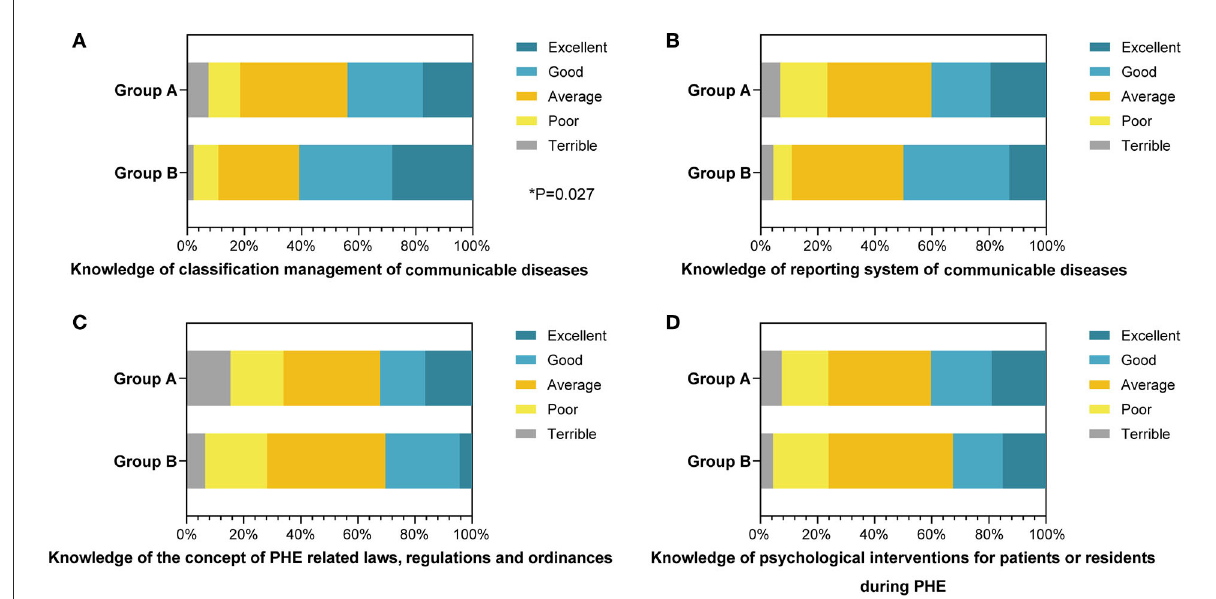
FIGURE4 The percentage stacking histograms of the comparison in the mastery of public health emergency (PHE) regulations and psychological intervention abilities between clinical and preventive medical students with a 5-point Likert scale. (A) The knowledge of classification management of communicable diseases between clinical and preventive medical students. (B) The knowledge of reporting system of communicable diseases between clinical and preventive medical students. (C) The knowledge of the concept of PHE-related laws, regulations, and ordinances between clinical and preventive medical students. (D) The knowledge of psychological interventions for patients or residents during PHE between clinical and preventive medicine students. The nonparametric test was applied for the comparison (The number of group A is n1 = 189; the number of group B is n2 =